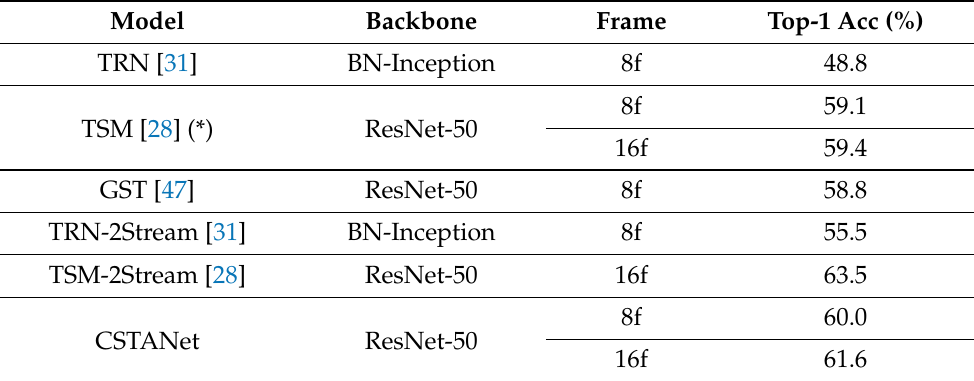
Table 4. State-of-the-art results on the Something-Something V2: * denotes that 5 crops are